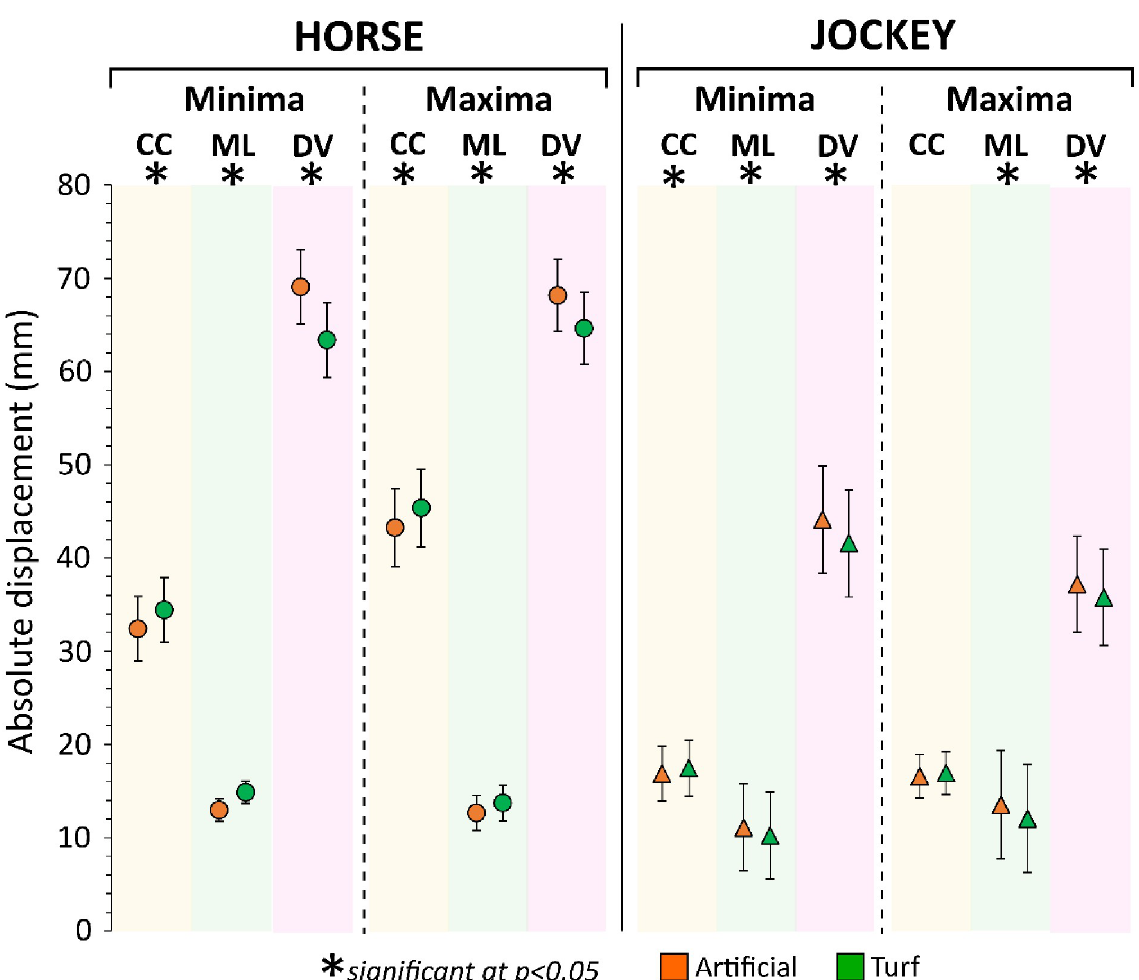
Fig 9. Output of linear mixed models for surface effects. Estimated marginal means with 95% confidence interval are presented per displacement parameter. CC = cranio-caudal, ML = medio-lateral, DV = dorso-ventral.